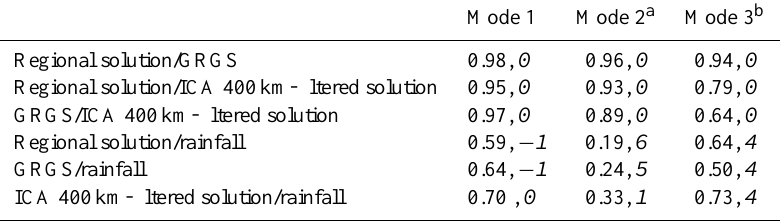
Table 2. Cross-correlation maxima values and corresponding temporal lag in number of months (second value in italic) between PCA temporal components (mode 1, 2 and 3) of different GRACE-based data sets regional solutions, GRGS and ICA 400km-filtered solution, as well as rainfall BoM product. Data derived from regional and GRGS are filtered and interpolated to monthly resolution. The time lag represents the time delay between water mass variations derived from GRACE and the observed